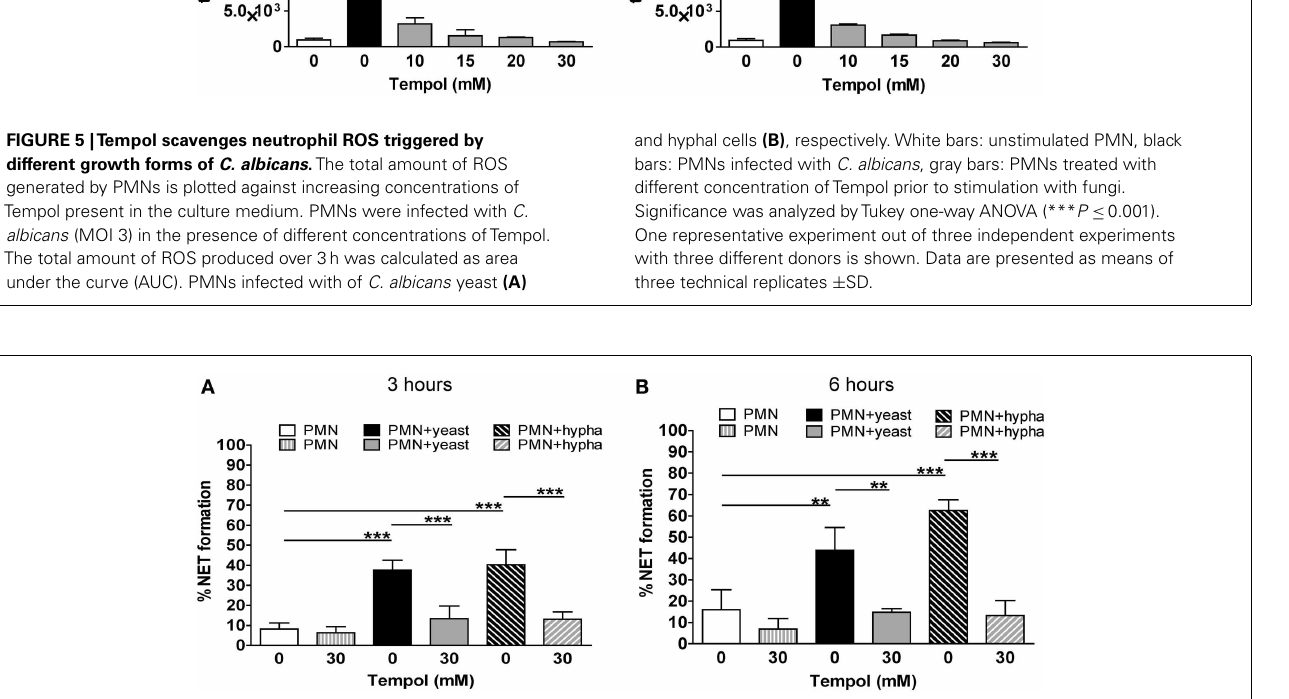
yeast, diagonal dashed black bars: PMNs stimulated with C. albicans hyphae, diagonal dashed gray bars: PMNs treated withTempol prior to infection with hyphae.The percentage of cells undergoing NET formation was calculated as explained in materials and methods. Significance was analyzed byTukey one-way ANOVA (** P ≤ 0.01 and *** P ≤ 0.001). Data are presented as means ± SD of three independent experiments with three different